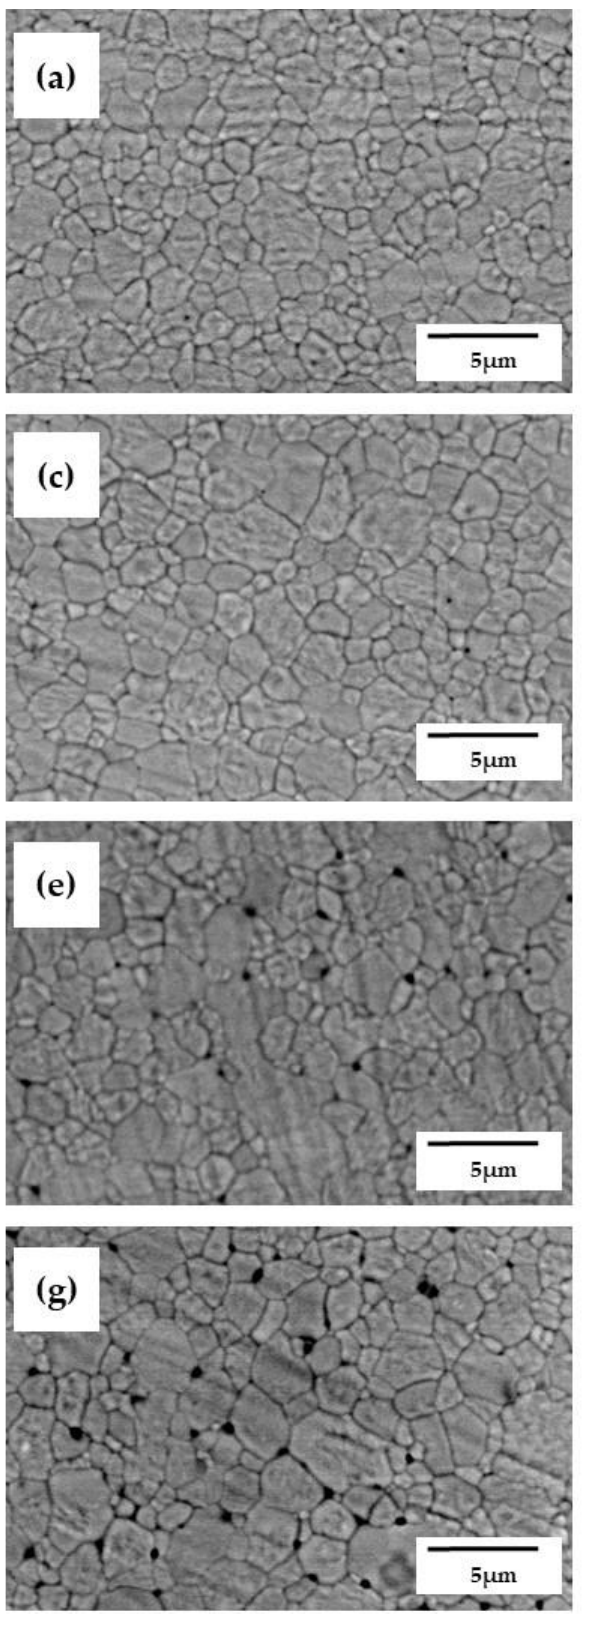
Figure 7. Scanning electron micrographs of: ( a , c , e , g ) 5Y-SS-1.9, 4.0, 8.0, 18, ( b , d , f , h ) 5Y-CS-1.9, 4.0, 8.0, 18.